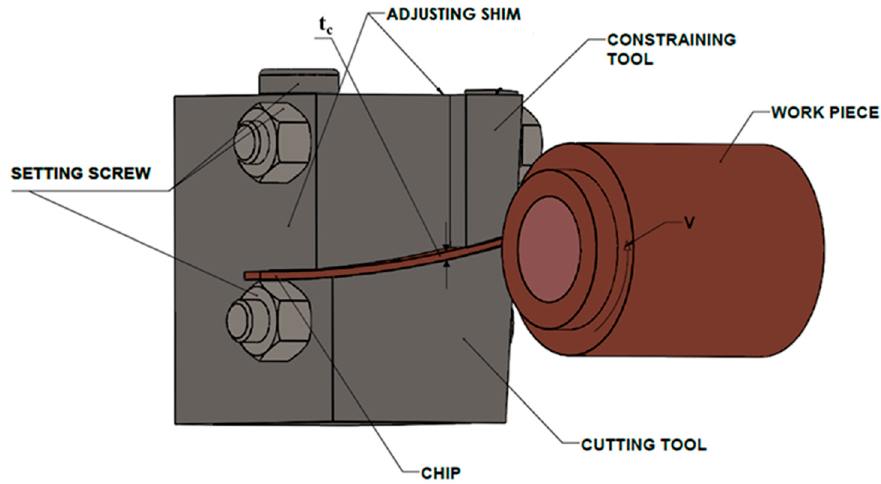
Figure 8. Turing-based LSEM experimental setup.